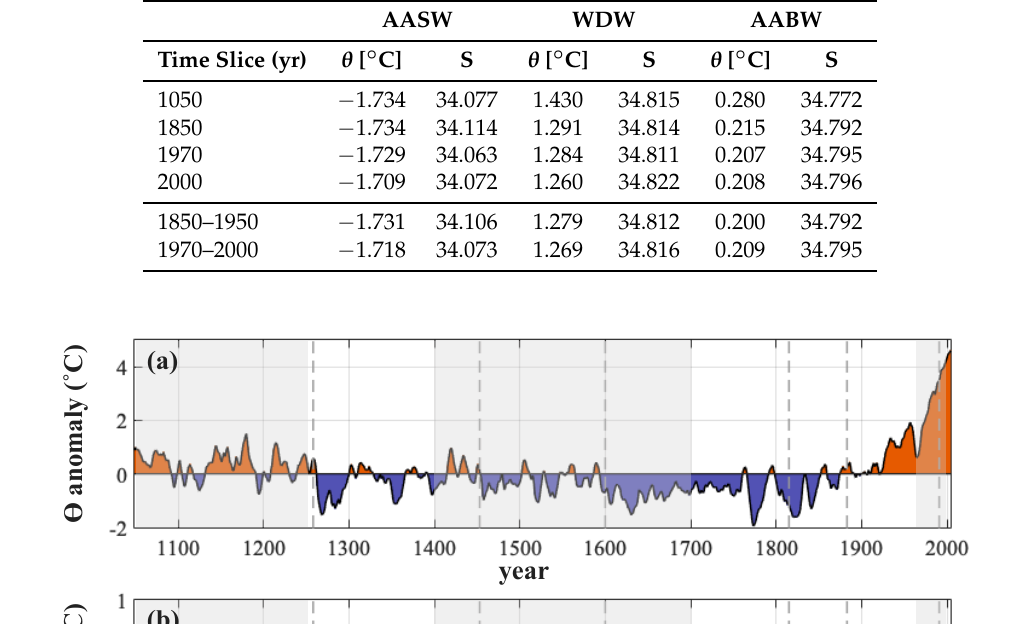
Table 1. Ensemble mean Sea Water Types extracted from θ –S diagrams for AASW, WDW and AABW used in OMP analysis for specific time slices/ranges of the CESM-LME experiment simulation period.